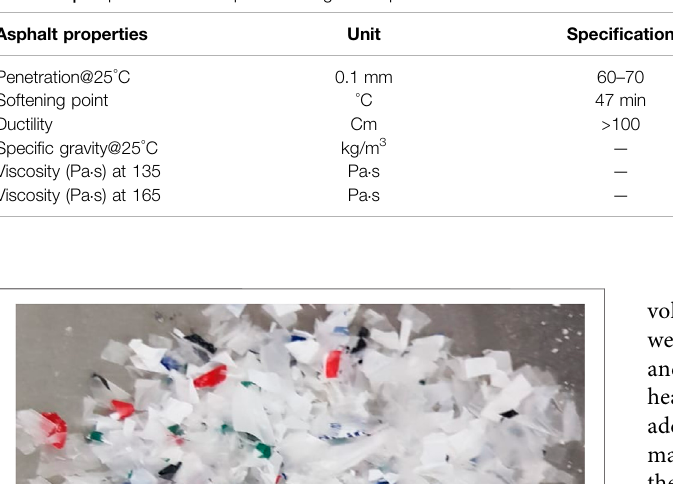
TABLE 1 | Properties of 60/70 penetration grade asphalt